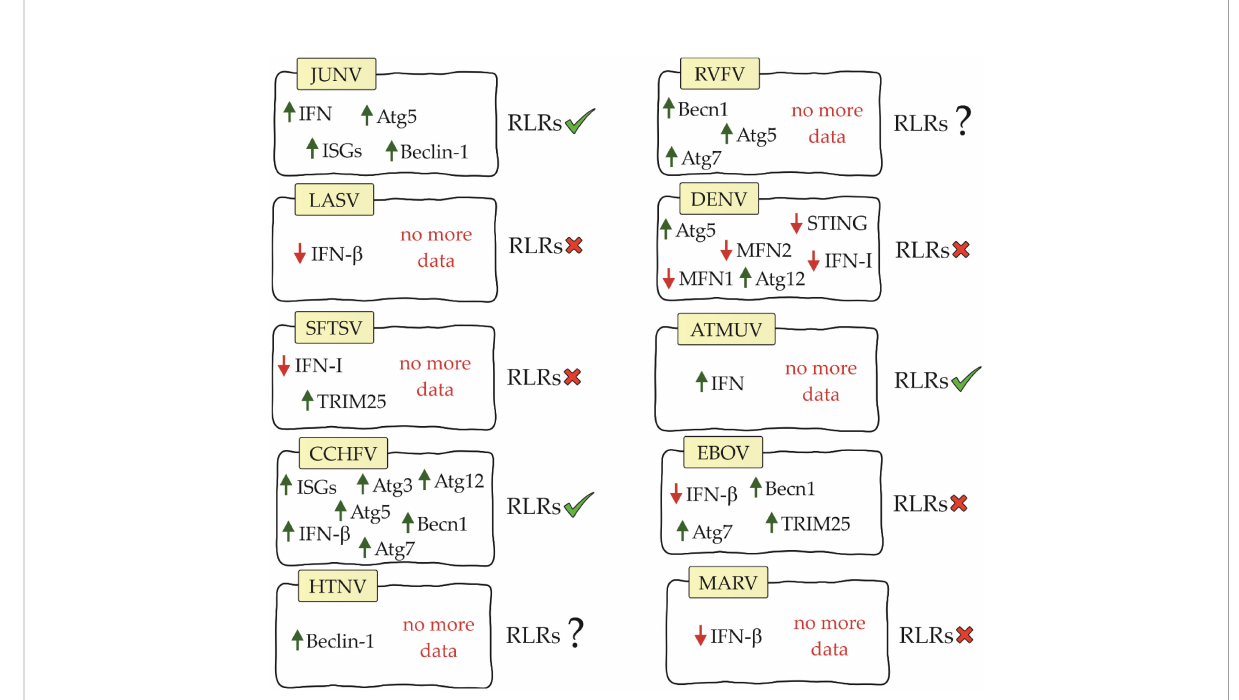
FIGURE 3 Diagram showing relationship between RIG-I-like receptors, their factors and viral hemorrhagic fevers (JUNV, Junín virus; LASV, Lassa virus; SFTSV, severe fever with thrombocytopenia syndrome virus; CCHFV, Crimean-Congo hemorrhagic fever virus; HTNV, Hantaan virus; RVFV, Rift Valley Fever Virus; DENV, dengue virus; ATMUV, avian Tembus virus; EBOV, Ebola virus; MARV, Marburg virus; RLRs, RIG-I-like